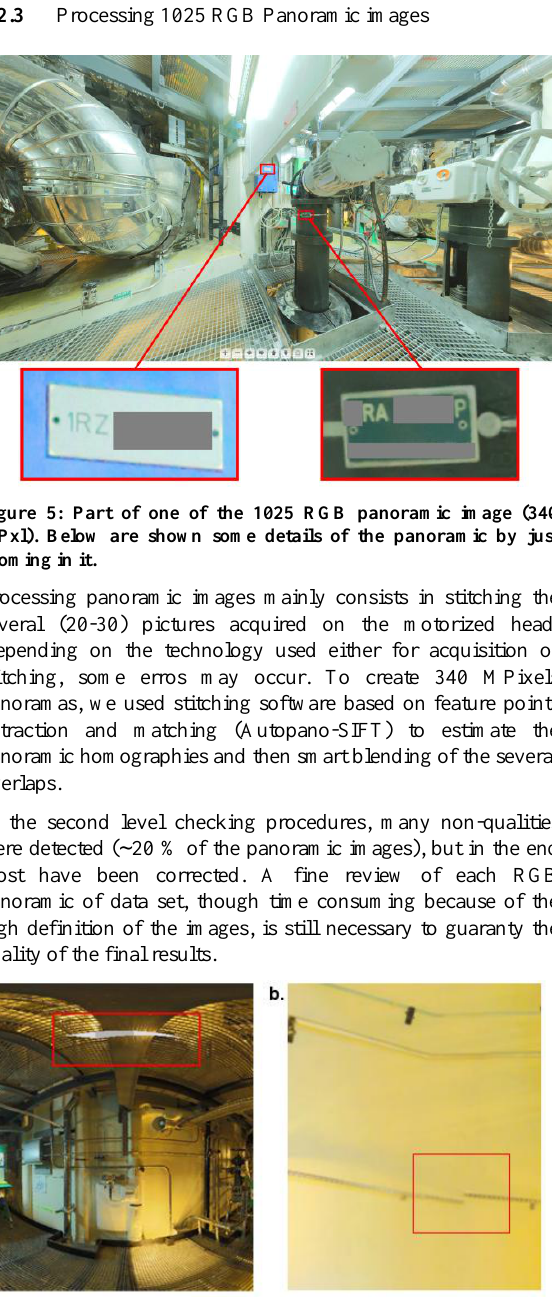
Figure 6: Typical non-qualities found on panoramic images that needs a re-process before storing and sharing. a. Hole in the panoramic due to wrong calculation of panoramic homographies. b. Shearing due to mismatching of original